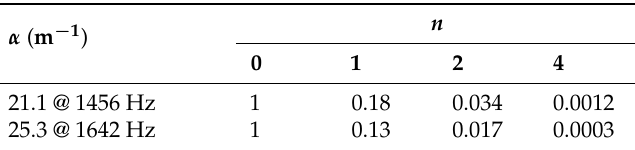
Figure 3. ( a ) numerical reflection coefficients for the single short (blue line) or the single long (red line) tube grafted onto a waveguide; ( b ) experimental and numerical transmission spectra for the single short tube grafted onto a waveguide; ( c ) pressure distribution field at the resonant frequency for the short tube; The color bar represents the normalized pressure with respect to the maximum pressure (Max) at the corresponding frequency; ( d ) experimental and numerical transmission spectra for the single long tube grafted onto a waveguide; ( e ) pressure distribution field at the resonant frequency for the long tube. Table 1. Amplitude decay of evanescent guided waves exp ( − α na ) as a function of the imaginary part of the wavenumber ( α ) and of the propagation distance na